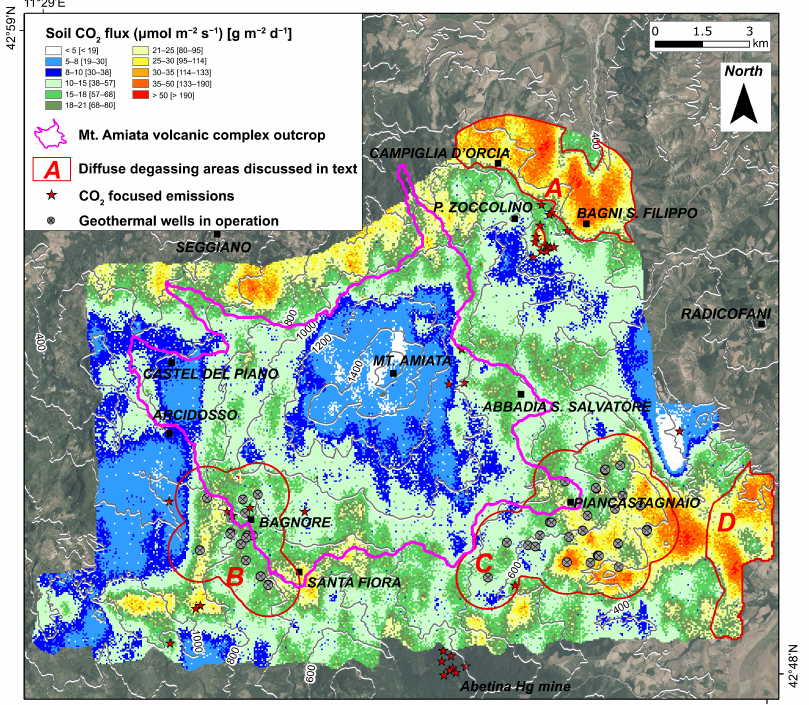
Figure 5. Soil CO 2 flux map with areas of Bagnore, Piancastagnaio (geothermal fields in operation, brownfields), Bagni San Filippo (geothermal greenfield), and Paglia River high emission areas. Red stars are the concentrated gas emissions and gas vents considered in the CO 2 total emissions budget in the atmosphere. The geothermal wells in operation used to define B and C areas are also reported (Enel Green Power